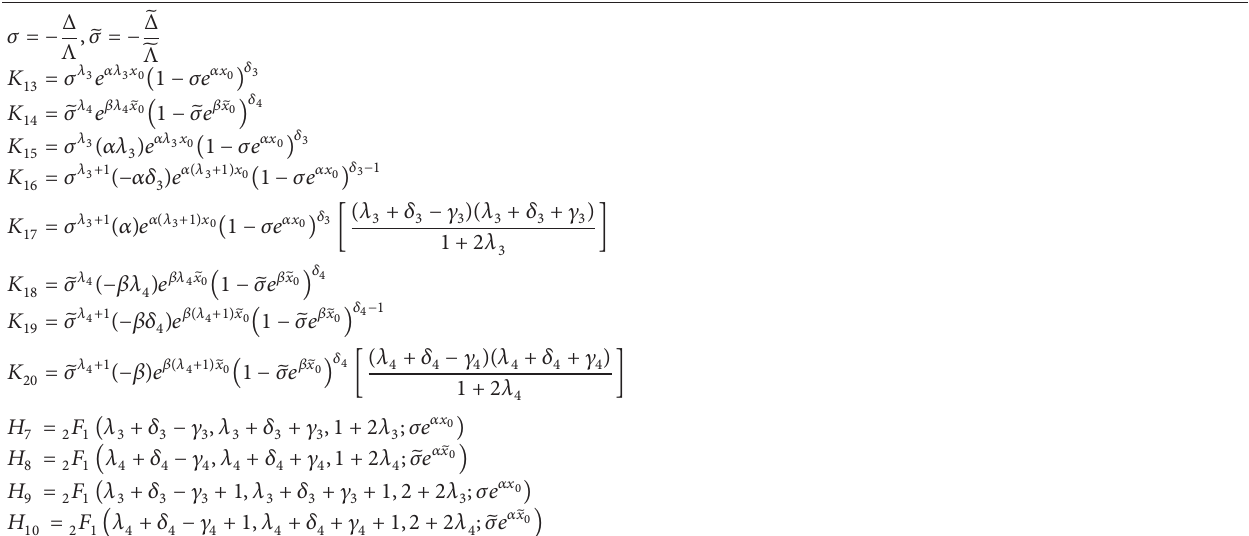
Table 3: The abbreviations defined in the calculations for the bound